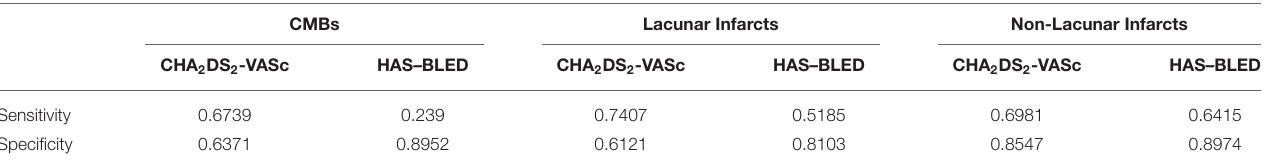
TABLE 5 | Sensitivity and specificity of re-weighted CHA 2 DS 2 -VASc and HAS–BLED scales with the addition of MoCA, SPPB, and GDS in relation to the three neuroimaging